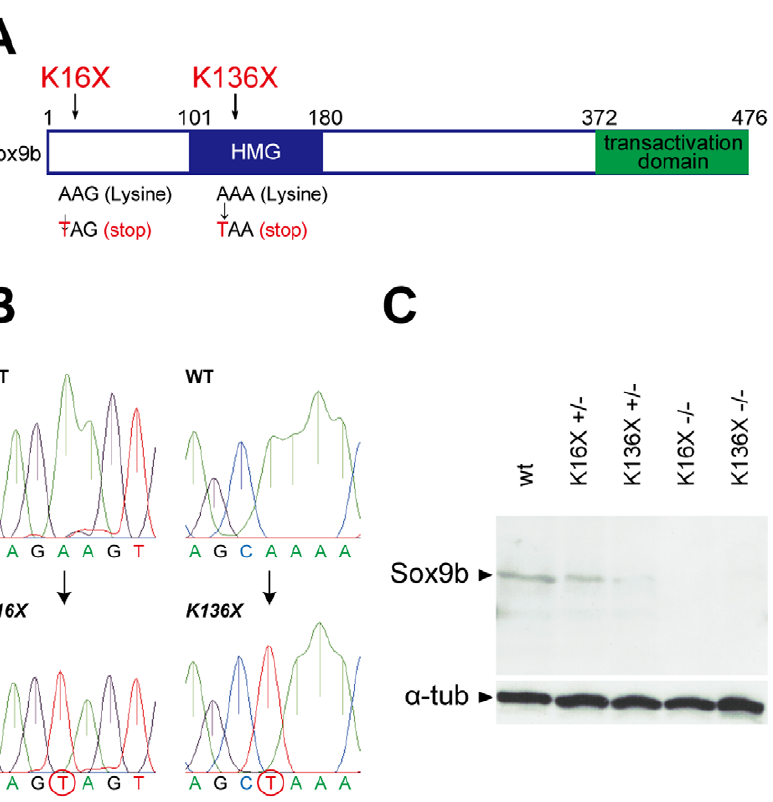
Figure 1. Identification and characterization of two sox9b mutant alleles in medaka. (A) Schematic representation of the sox9b medaka protein and the locations of mutations. (B) Genomic sequences of wild-type sox9b , and of the sox9b K16X ( 2 / 2 ) and sox9b K136X ( 2 / 2 ) mutants. (C) Western blotting analysis of sox9b and alpha-tubulin demonstrating the absence of expression in the homozygous mutants, confirming that both alleles are null.